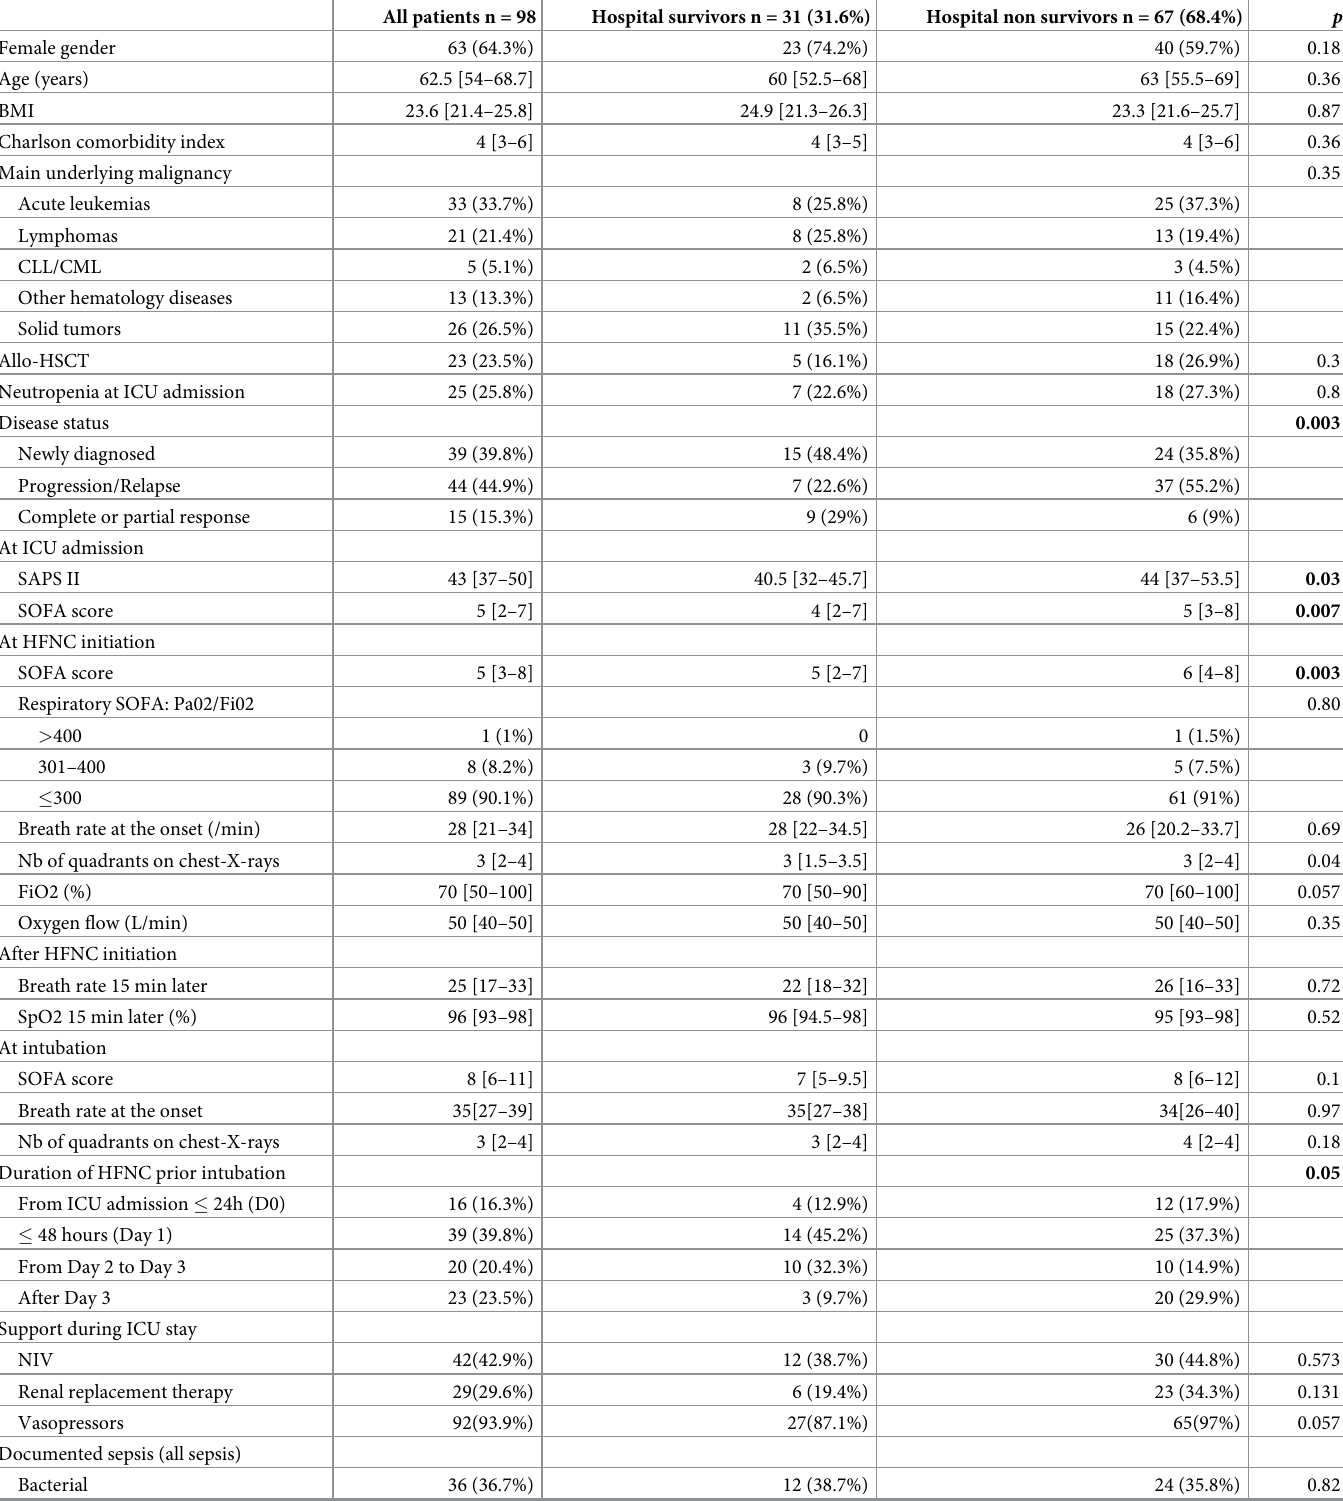
Table 1. Characteristics of patients experiencing HFNC therapy